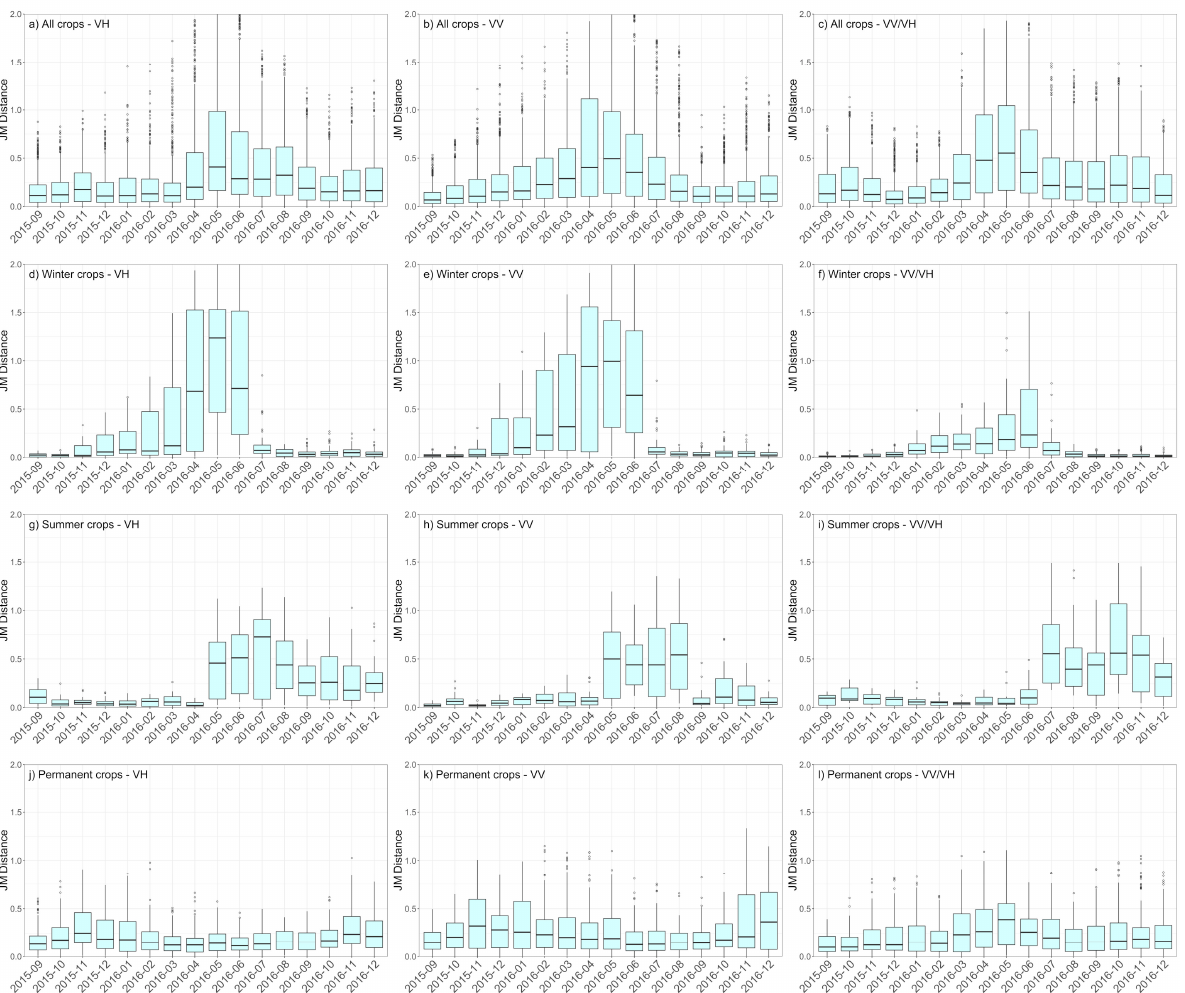
Figure 5. Monthly boxplots of JM distance for the three polarizations (VH, VV and VH/VV), reflecting the separability between all crops ( a , b , c ), winter crops ( d , e , f ), summer crops ( g , h , i ), and permanent crops ( j , k , l ).